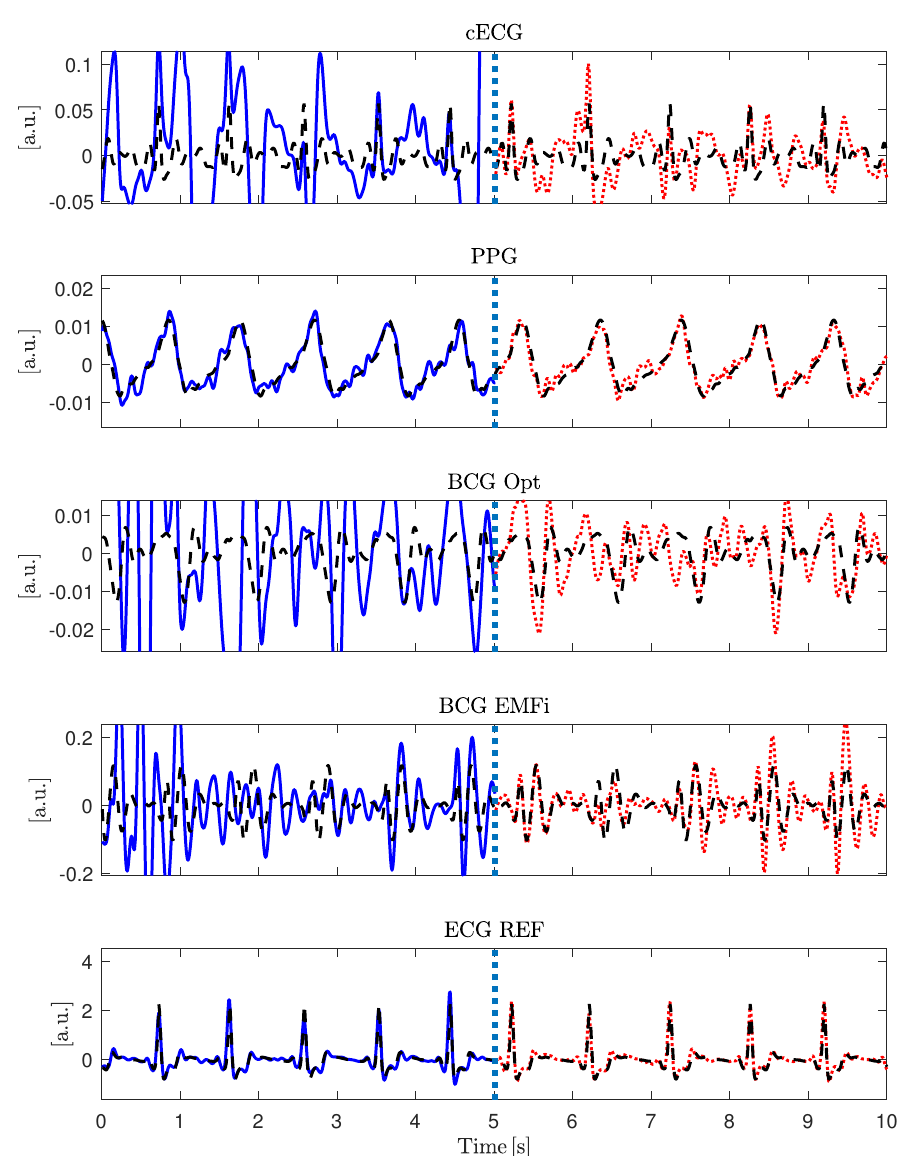
Figure 5. Visualization of the signal approximation step of the SNR S calculation for all modalities. The dashed vertical line separates the artifact segment from the artifact free period. The solid blue line represents the signal recorded during movement, the red pointed line after the movement has stopped. The black dashed line represents the approximation of the signal based on the extracted template and the reference segmentation. Note that, for this specific example, ECG REF and PPG are almost unaffected by the